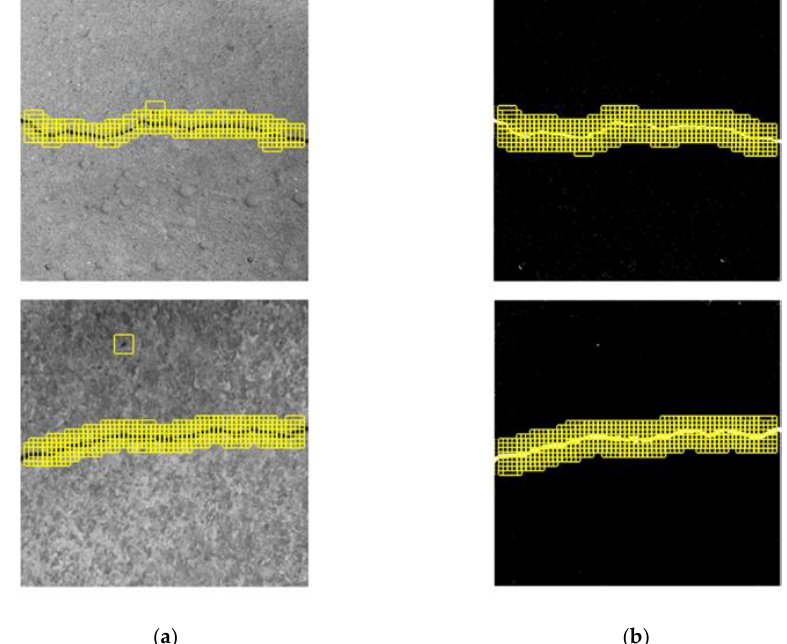
Figure 23. Results of crack position detection (CPD) based on ( a ) the original CPD and ( b ) the MLP–CNN, with uneven concrete surfaces.